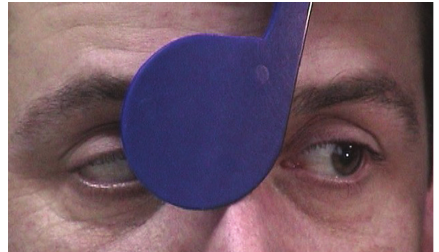
Figure 7: Full abduction of left eye on ductions.